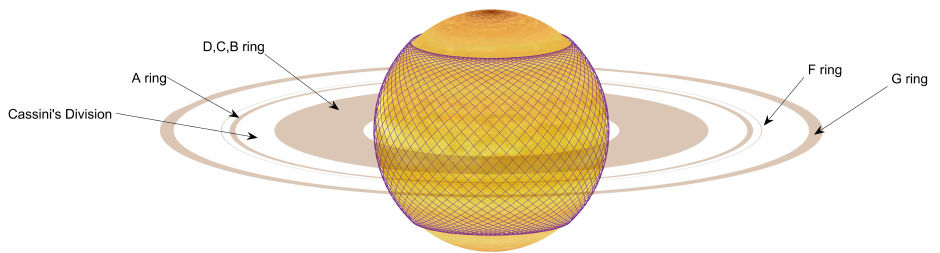
Figure 6. The repeating ground track orbit around Saturn for a = 61539 km, i = 133.2052 deg, e = 0.001, ω = 45 deg, Ω = 30 deg, and repetition parameter Q =